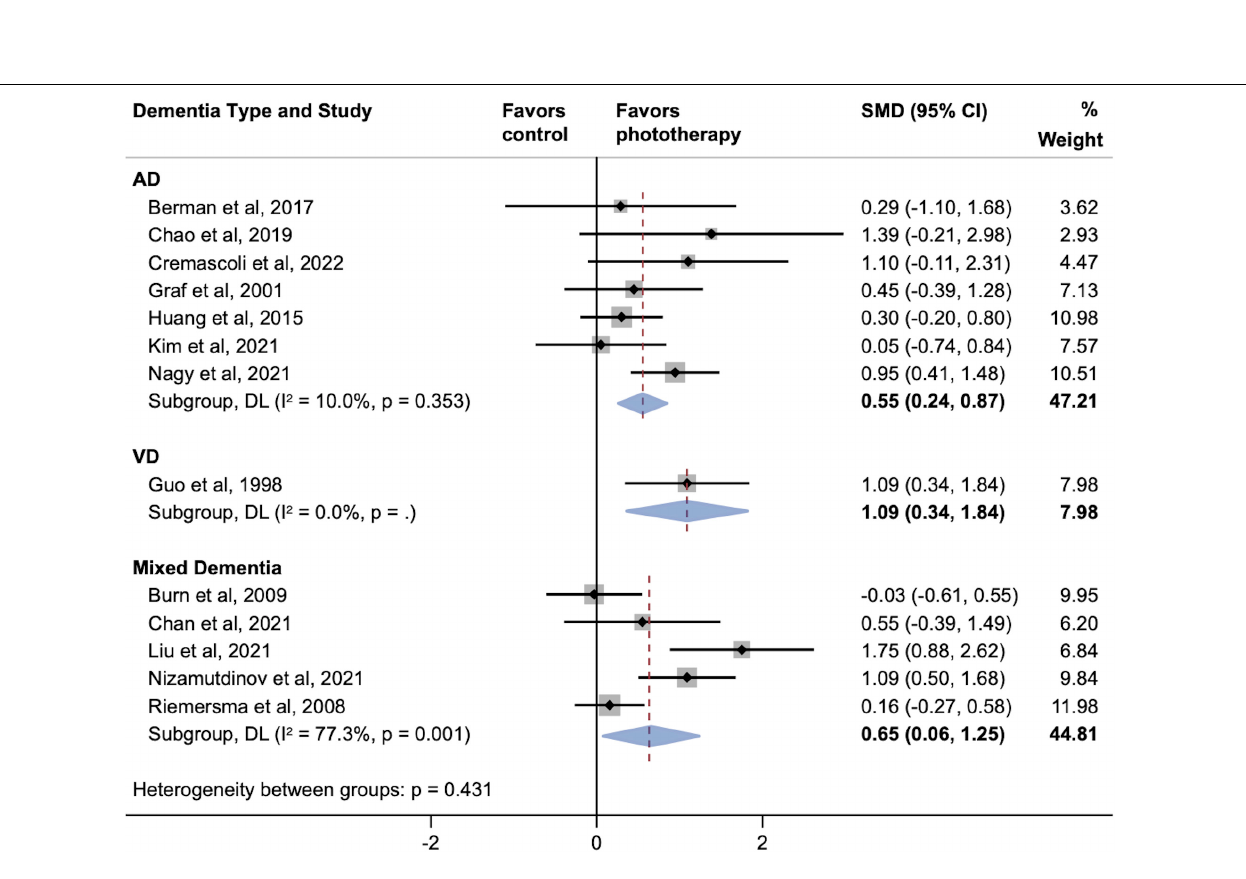
FIGURE 5 | Subgroup analyses evaluating cognitive improvement, stratified by types of dementia. AD, Alzheimer’s disease; SMD, standardized mean difference; VD, vascular dementia. Weights and between-subgroup heterogeneity test are from random-effects model.